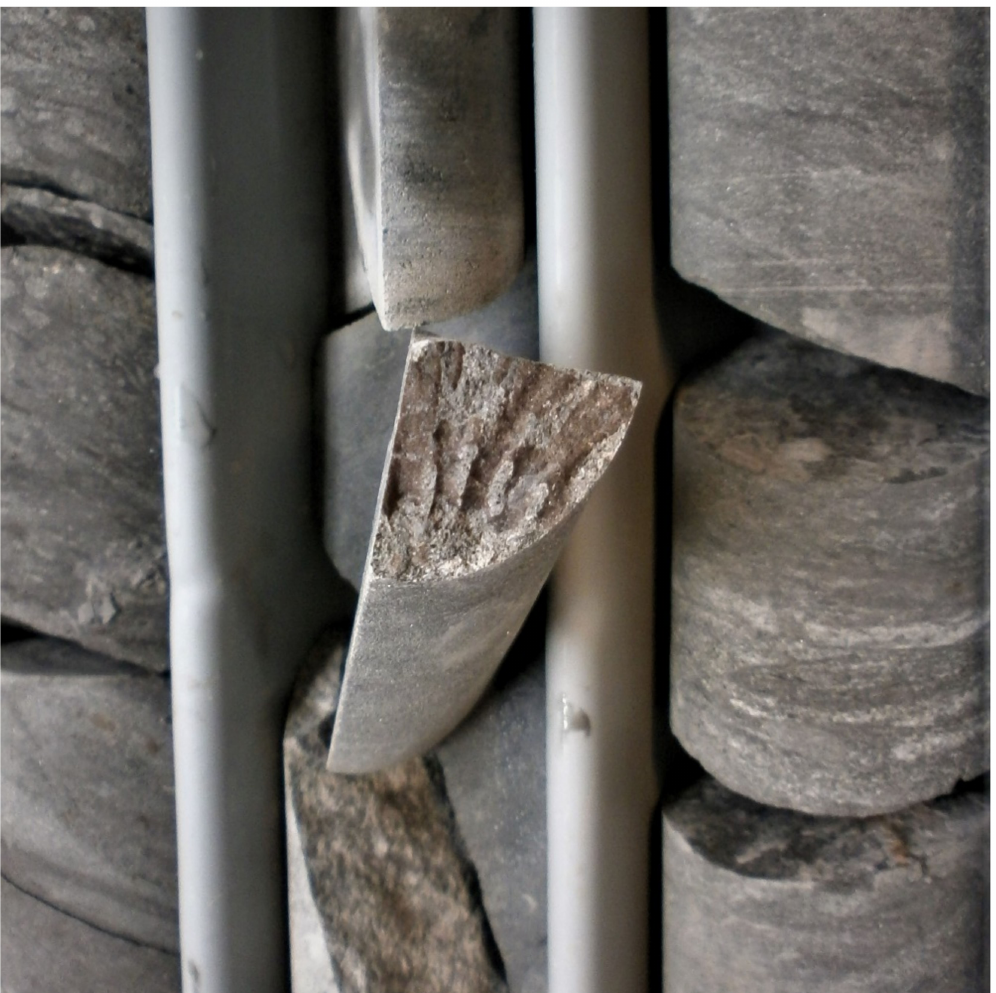
Figure 5. Fragment of a craspeditid ammonite resembling Surites (Bojarkia) cf. mesezhnikowi (Berriasian age) found at 159.80 m in borehole Bh